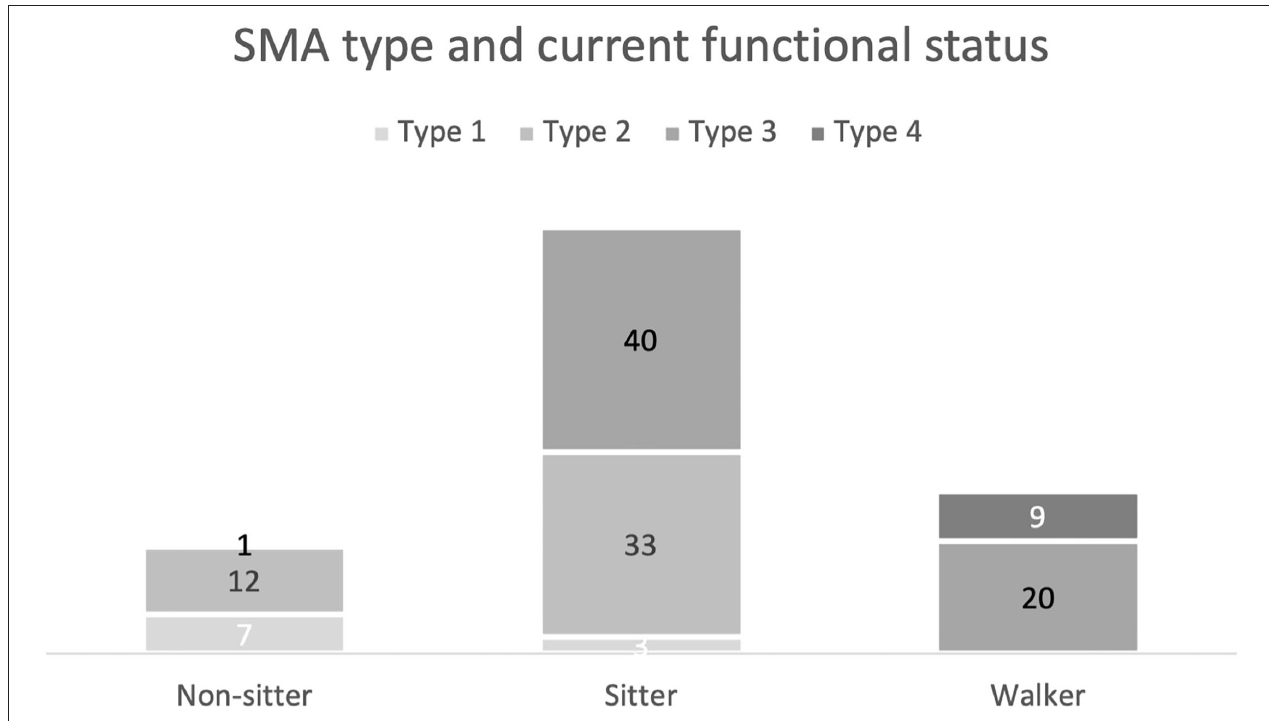
FIGURE 1 | SMA type and current functional status distribution.